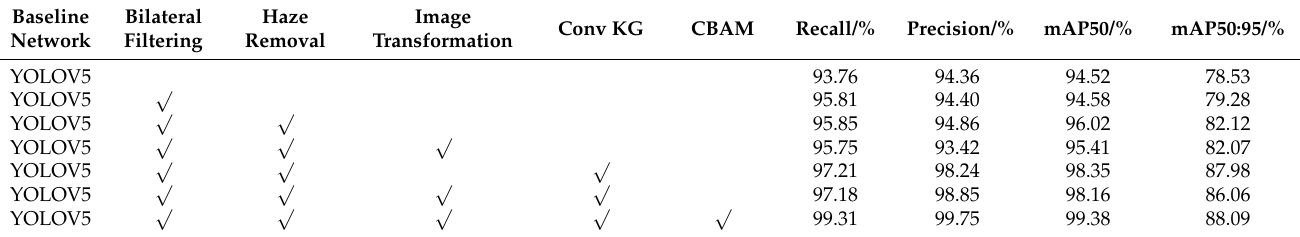
Table 5. The results of an ablation test.